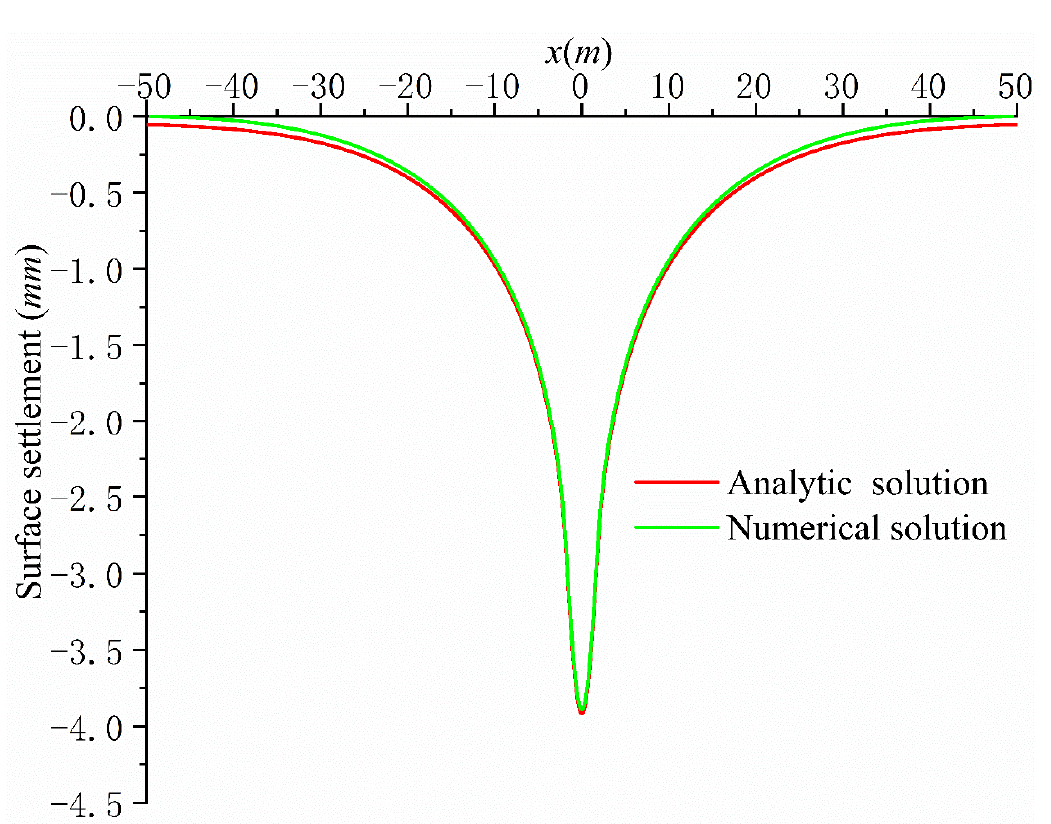
Figure 9. Comparison between analytical solution and numerical solution of surface settlement.